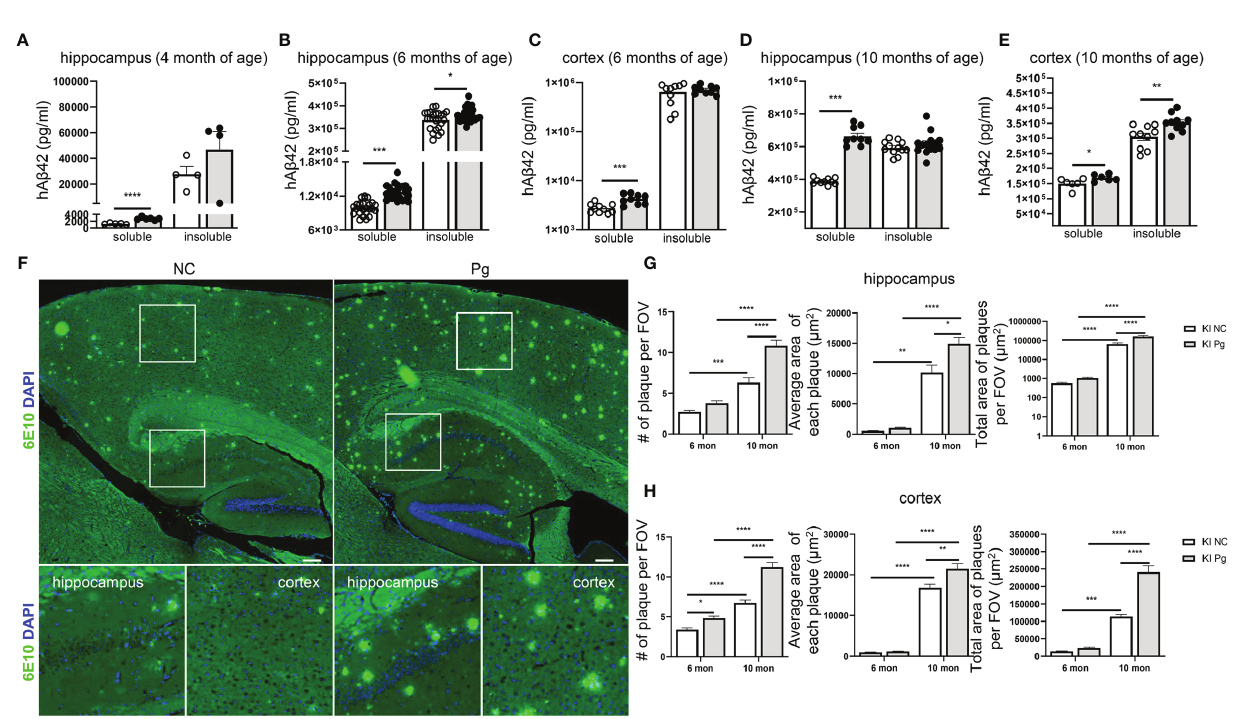
FIGURE 3 | Pg infection accelerates A b production and plaque formation in App KI mice. (A – E) Levels of soluble and insoluble hA b 42 in the brains of control and Pg-infected App KI mice at 4, 6 and 10 months of age. A, n=4-6/group; B, n=24/group; C-E, n=6-10/group. Samples were run in duplicate in ELISA. (F) Representative micrographs showing A b plaques formation in App KI mice at 10 months of age. Whole brain images were stitched with 30 series micrographs captured at 10 x objective using a KEYENCE BZ-800 microscope. Boxed areas were further enlarged. A b plaques were labeled with 6E10 (green) and cell nuclei were labeled with DAPI (blue). (G, H) Quanti fi cation of the number of A b plaques, average plaque size, and total plaque-occupied area per fi eld of view (FOV) in the hippocampus (G) and cortex (H) of App KI mice at 6 and 10 months of age. Five representative regions of the cortex and hippocampus were captured at 40x objective from each brain section and quanti fi ed (n=5-7/group). Data are expressed as mean ± SEM. * P < 0.05, ** P < 0.01, *** P < 0.001, **** P < 0.0001 by unpaired Student t -test (A – E) , or by two-way ANOVA followed with Tukey correction (G, H)